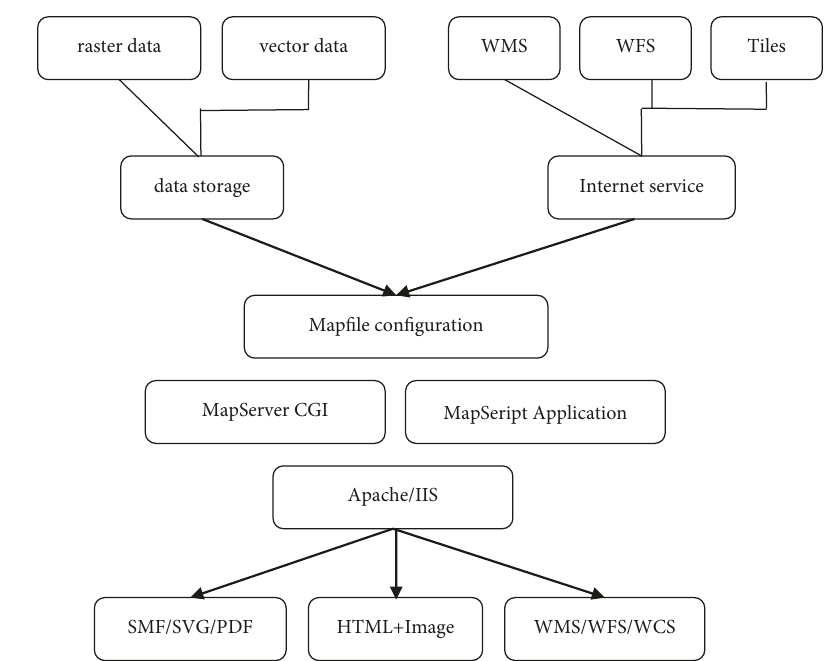
Figure 2: Mapserver working principle